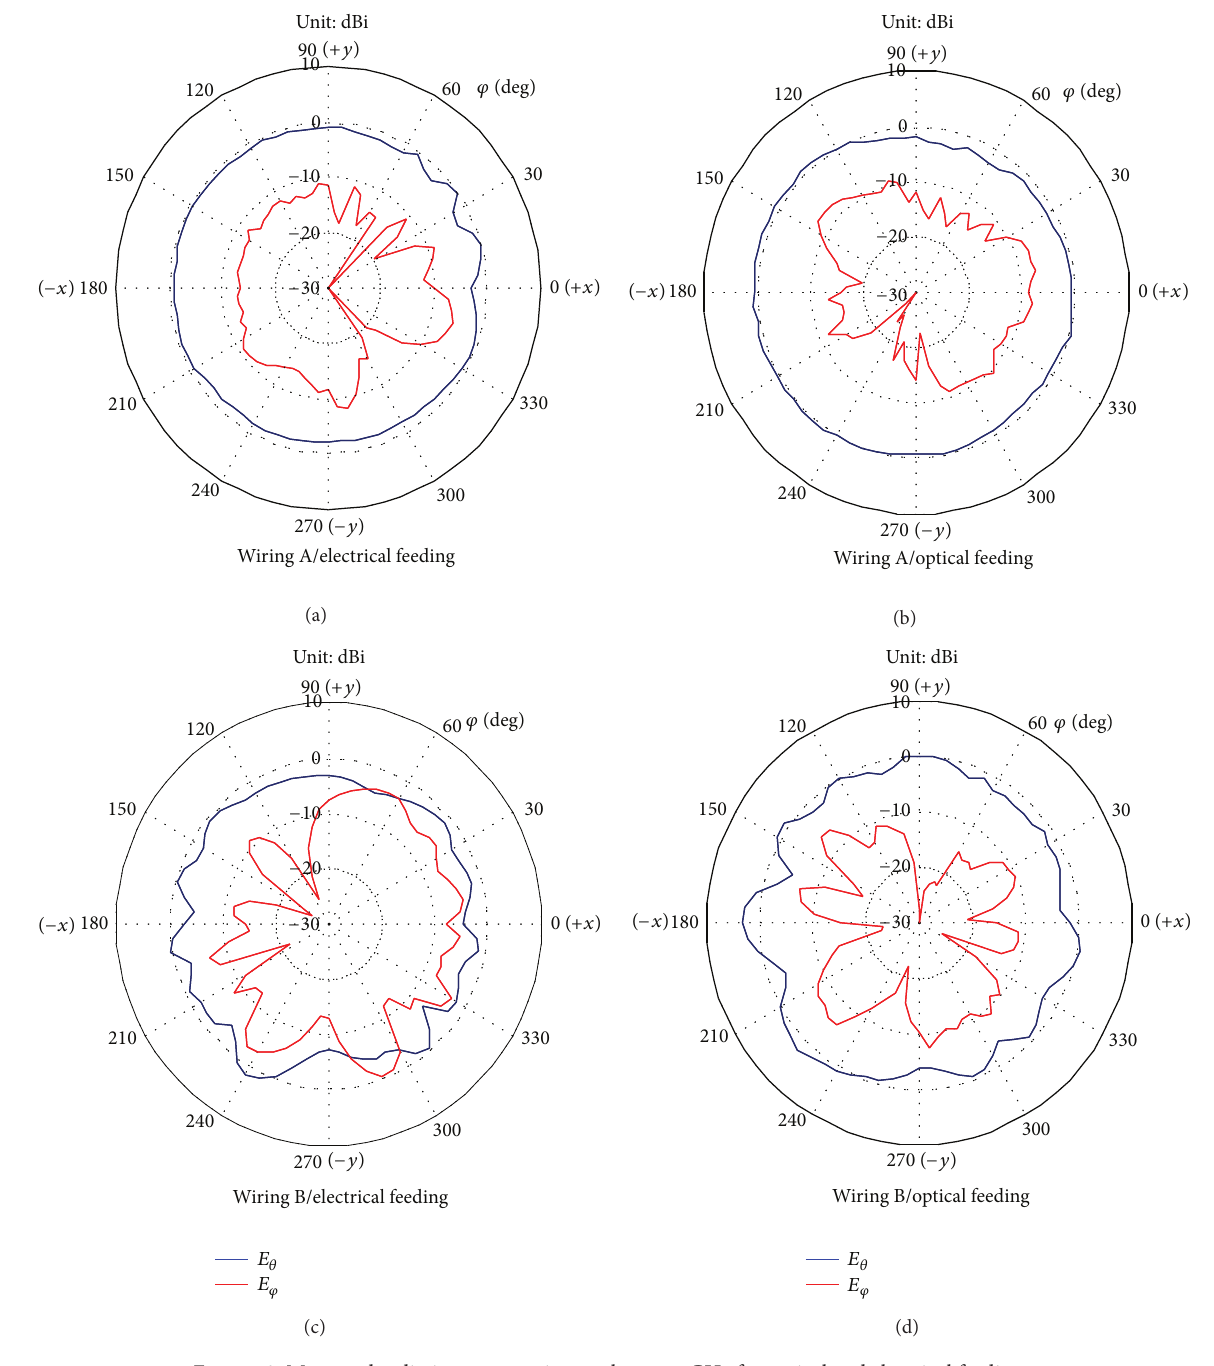
Figure 8: Measured radiation patterns in 𝑥𝑦 -plane at 5GHz for optical and electrical